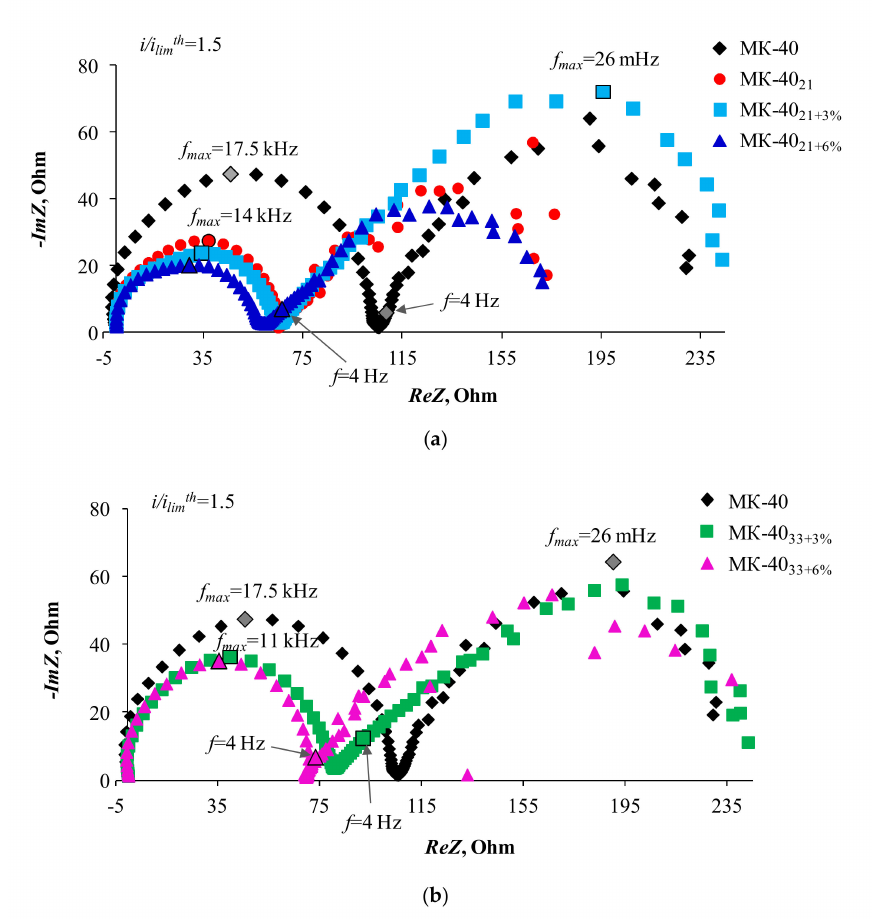
Figure7. ElectrochemicalimpedancespectraoftheMK-40aswellasMK-40 21 ,MK-40 21 + 3% ,MK-40 21 + 6% ( a ) and MK-40 33 + 3% , MK-40 33 + 6% ( b ) samples at i / i th